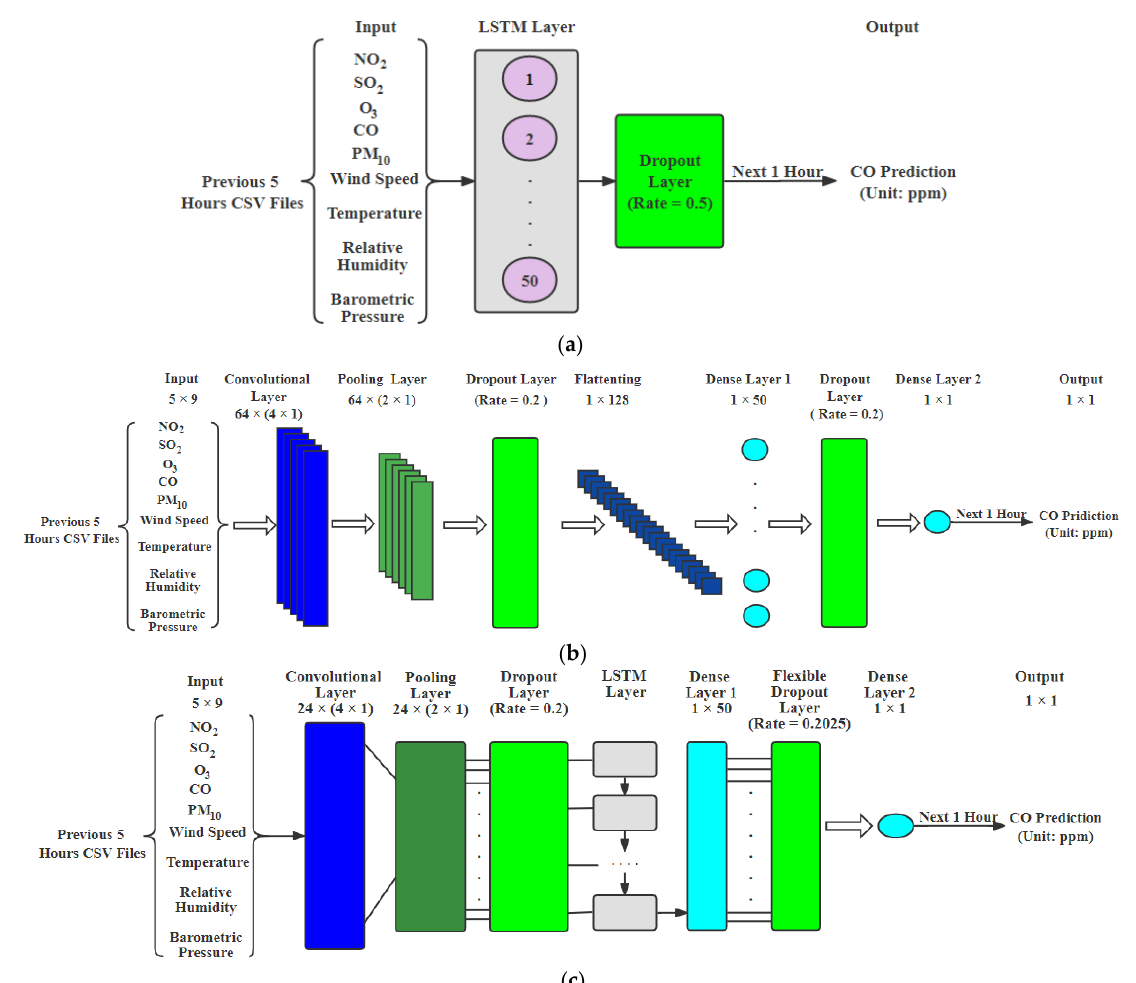
Figure 1. Hourly CO prediction models: ( a ) LSTM model; ( b ) CNN model; ( c ) DFN model (created by author).